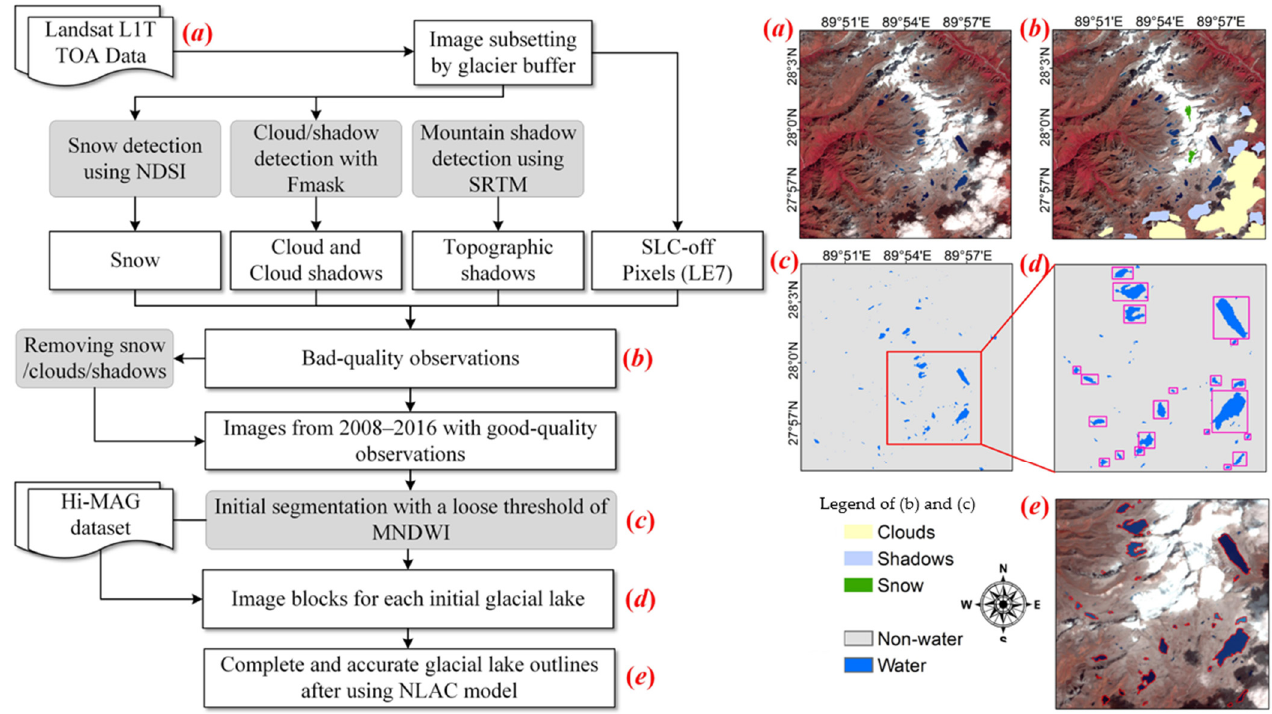
Figure 2. Automated lake mapping procedure ( left ) including image subsetting, snow, cloud, shadow, and SLC-off pixel detection, global threshold segmentation, generation of an image block for each glacial lake obtained from Hi-MAG dataset and initial segmentation results, and local glacial lake mapping. Lake mapping procedures taking one area in the central Himalayas as an example ( right ): ( a ) false color composite (R/G/B = Band 5/4/3) of original TOA data; ( b ) bad observation identification including clouds, shadows, and snow; ( c ) potential glacial lake extent found by applying an MNDWI threshold ( ≥ 0.1); ( d ) image block for each glacial lake; and ( e ) the final glacial lake shorelines determined using the NLAC model. The image used in this case was acquired by the Landsat-8 OLI on 28 October 2014. The sequence numbers ( a – e ) in the left-hand diagram correspond with those in the right-hand parts.